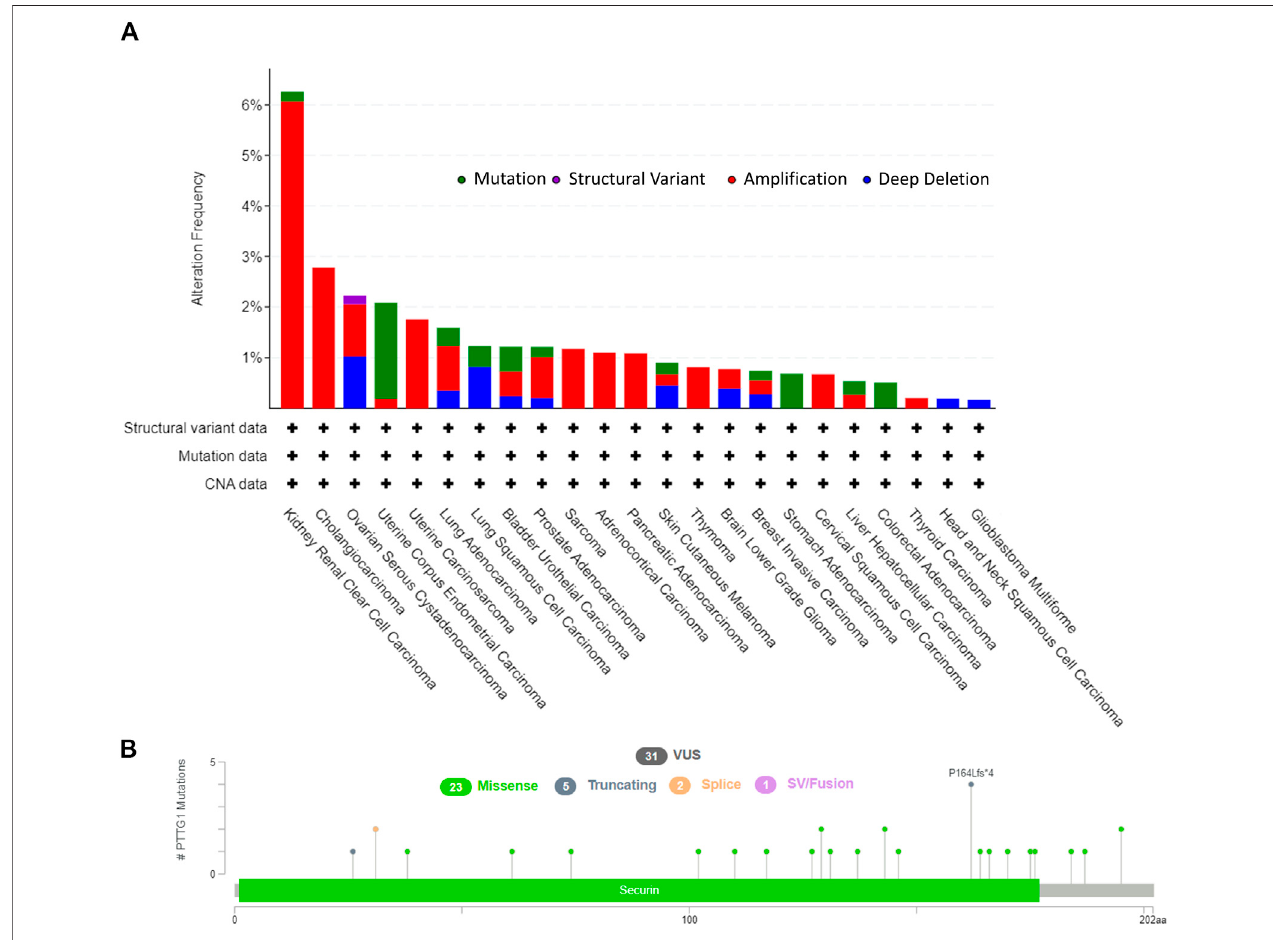
FIGURE 2 | The genetic alteration of PTTG1 in various of tumors. (A) The alteration frequency with corelative type was displayed for each tumor. (B) The mutation types, sites and case number of PTTG1 genetic alteration were displayed. VUS: variant of uncertain (or unknown) signi fi cance.